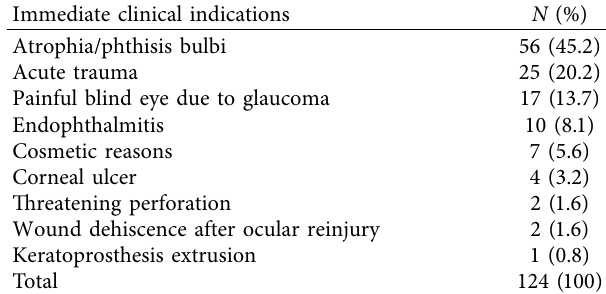
Table 4: Immediate clinical indications for enucleation/eviscera- tion due to ocular trauma (last diagnosis before anophthalmic